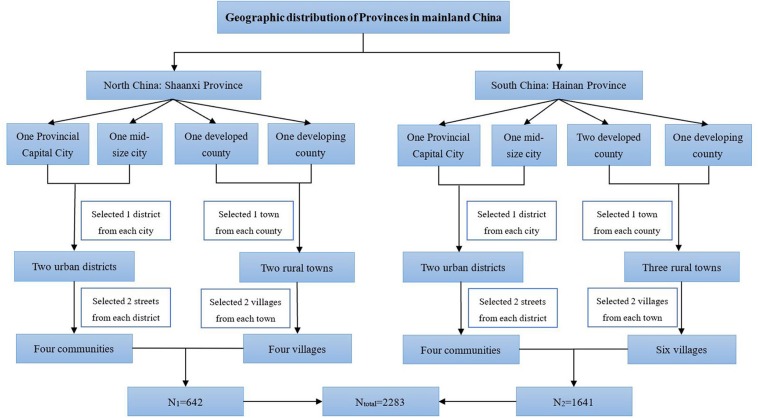
Flow chart of the sampling method. A multi-stage stratified cluster sampling method was used in 2013 to enroll children and adolescents aged 7–18 years of China (23).